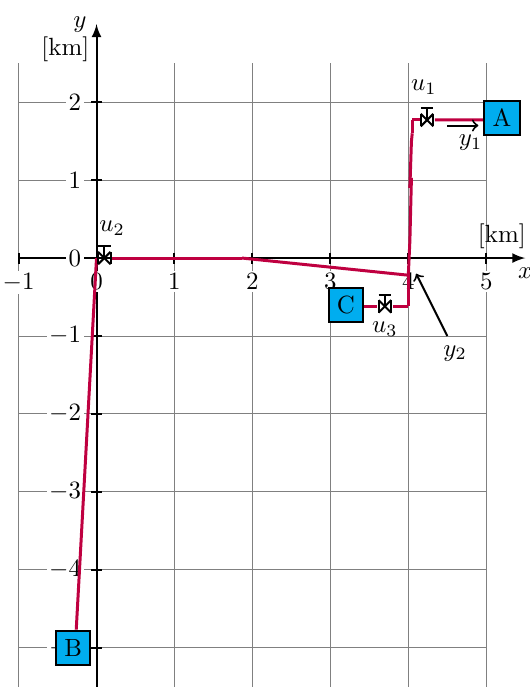
Figure 1: Illustration of the 3-phase well-pipeline-riser process integrated in the K-Spice/LedaFlow